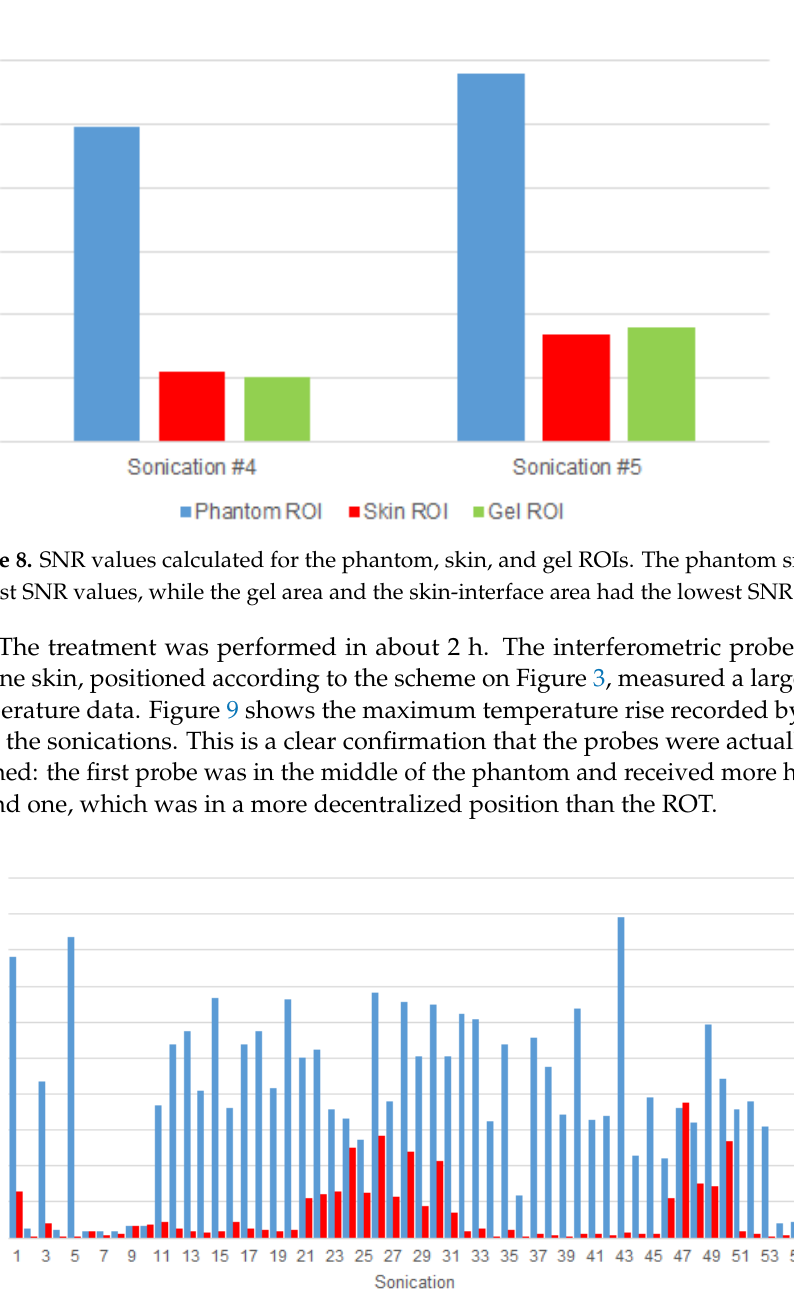
Figure 9. Maximum rise of temperature in each sonication for probe 1 (blue) and probe 2 (red). In some sonications, temperature-rising measurements were weakly perceived ( ∆ T < 1 ◦ C) for the relative position along the hypersonic field; this was the case in the fourth sonication (Figure 10a). In other cases, like the fifth sonication, the temperature rose about 16 ◦ C (Figure